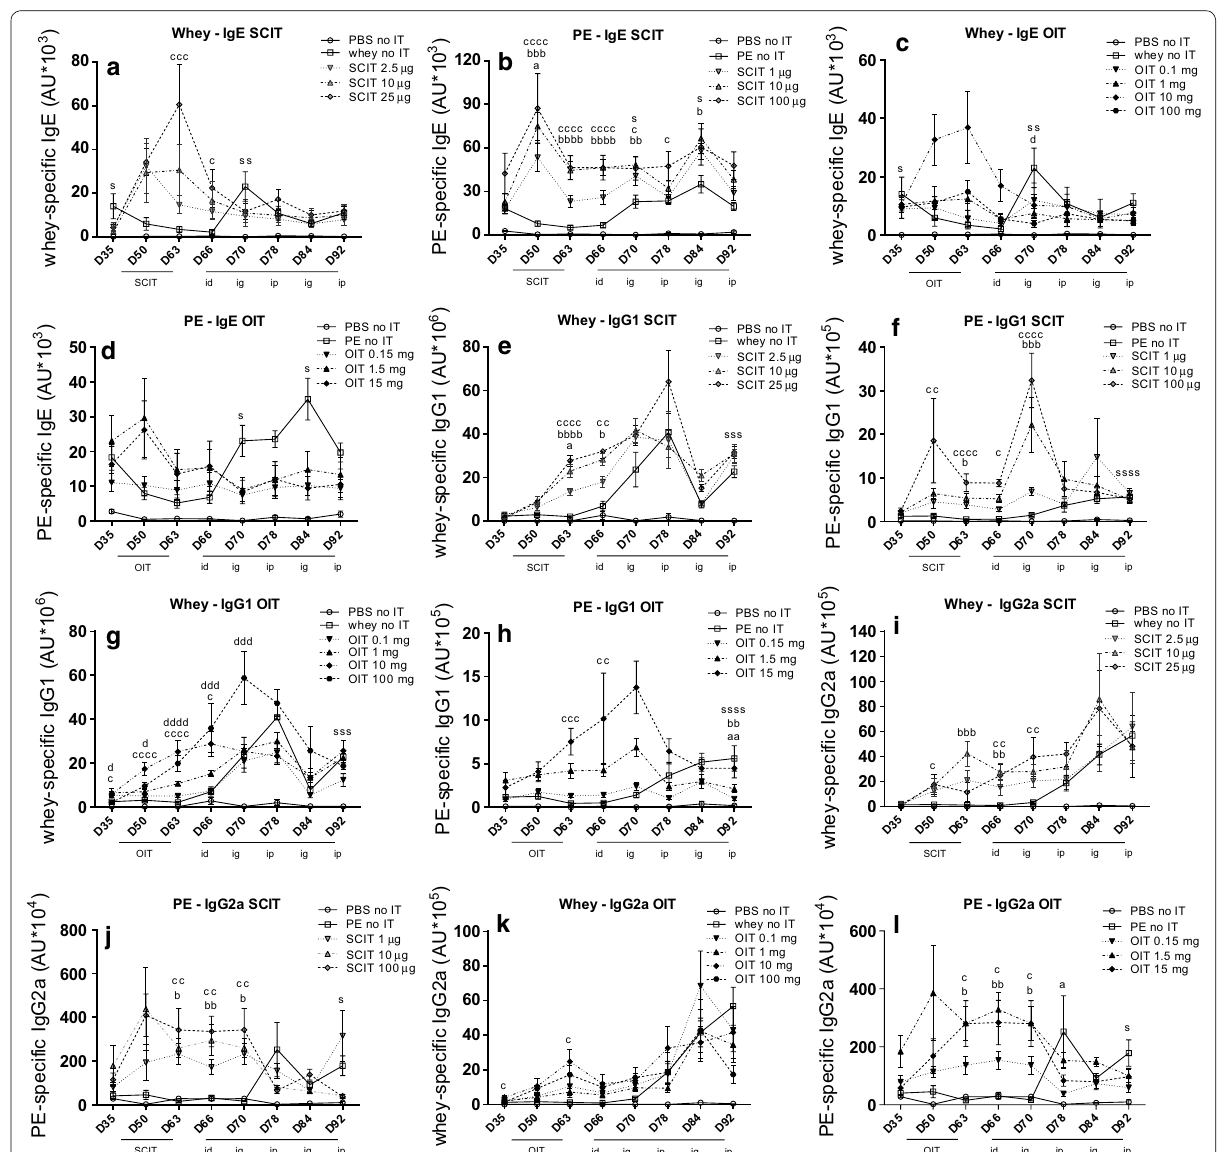
Fig. 3 Allergen-specific IgE, IgG1 and IgG2a levels in serum determined by ELISA. a , b Allergen-specific IgE in SCIT groups. c , d Allergen-specific IgE in OIT groups. e , f Allergen-specific IgG1 in SCIT groups. g , h Allergen-specific IgG1 in OIT groups. i , j Allergen-specific IgG2a in SCIT groups. k , l Allergen-specific IgG2a in OIT groups. Data are represented as mean SEM n 6–8 mice/group. Statistical analysis was performed on each ± = individual time point using one-way ANOVA and Dunnett’s post hoc test for multiple comparisons. All treatment groups were compared to the sen- sitized control group and significant differences were indicated with letters e.g. a P < 0.05; aa P < 0.01; aaa P < 0.001; aaaa P < 0.0001. In CMA figures: a for SCIT 2.5 μg and OIT 0.1 mg, b for SCIT 10 μg and OIT 1 mg, c for SCIT 25 μg and OIT 10 mg, d for OIT 100 mg and s for sham control. In PNA figures: a for SCIT 1 μg and OIT 0.15 mg, b for SCIT 10 μg and OIT 1.5 mg and c for SCIT 100 μg and OIT 15 mg and s for sham control. OIT oral immunother- apy, SCIT subcutaneous immunotherapy, IT immunotherapy, PE peanut extract, id intradermal challenge, ig intragastric challenge, ip intraperitoneal